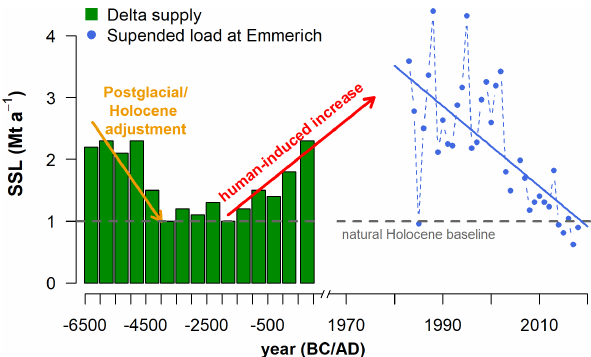
Figure 10. Reconstructed and monitored suspended sediment loads (SSLs) of the lower Rhine at the Dutch–German border. Re- constructed loads (green bars) are derived from a long-term sedi- ment budget analysis of the Rhine–Meuse delta in the Netherlands (Erkens, 2009). Blue points represent the suspended annual loads at the monitoring station in Emmerich (representing the most down- stream station of the German suspended monitoring